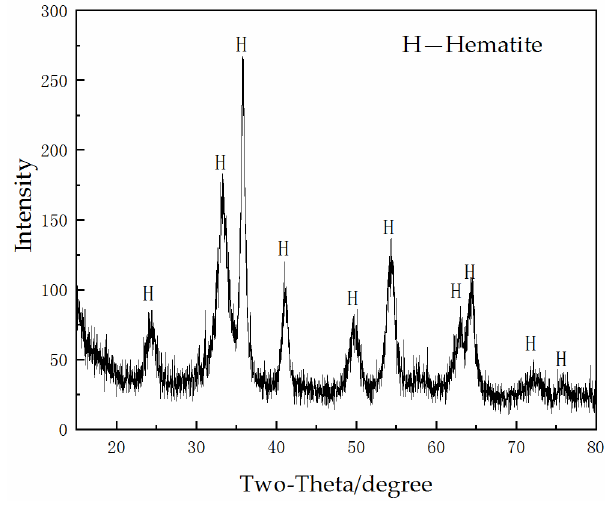
Figure 3. XRD pattern of calcined laterite (400 °C, 60 min).